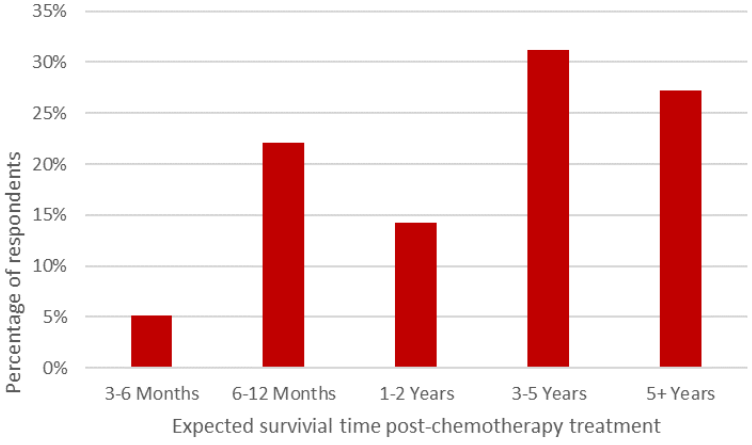
Figure 4. Perceived survival time post-chemotherapy treatment in dogs and cats.